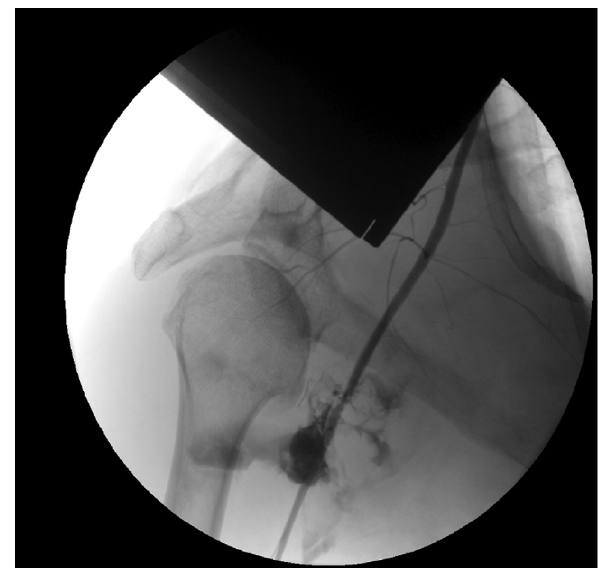
Figure 3. Disruption of the axillary artery on arteriography.